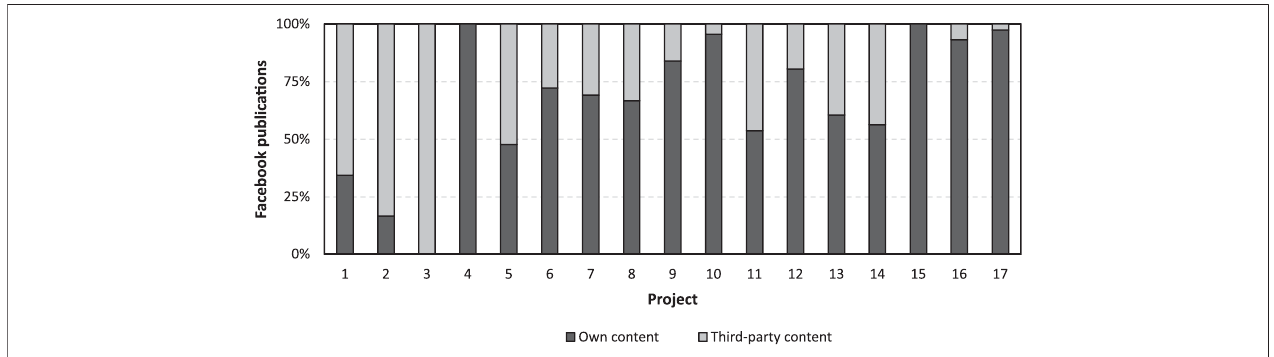
FIGURE 3 | Percentage of Facebook posts that corresponded to own content and third-party content, for each selected citizen science project.